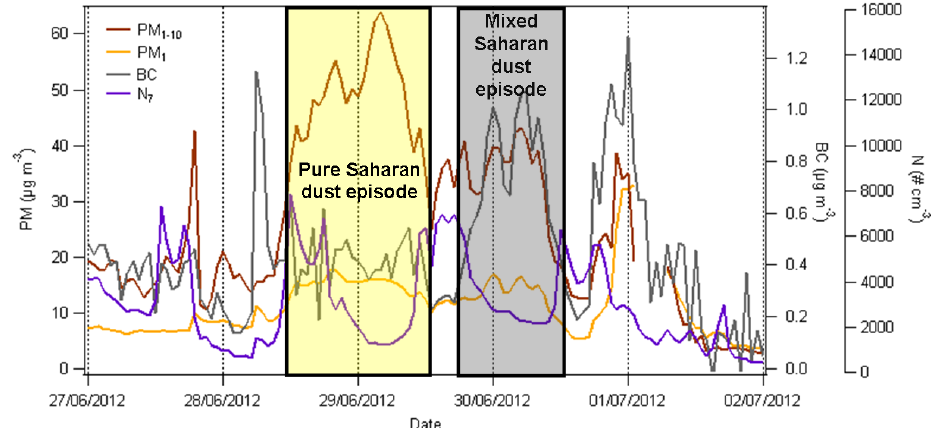
Fig. 6. Time series of PM 1 − 10 , PM 1 , BC and N concentrations under Saharan dust intrusion and wildfire episodes affecting the Montsec area.